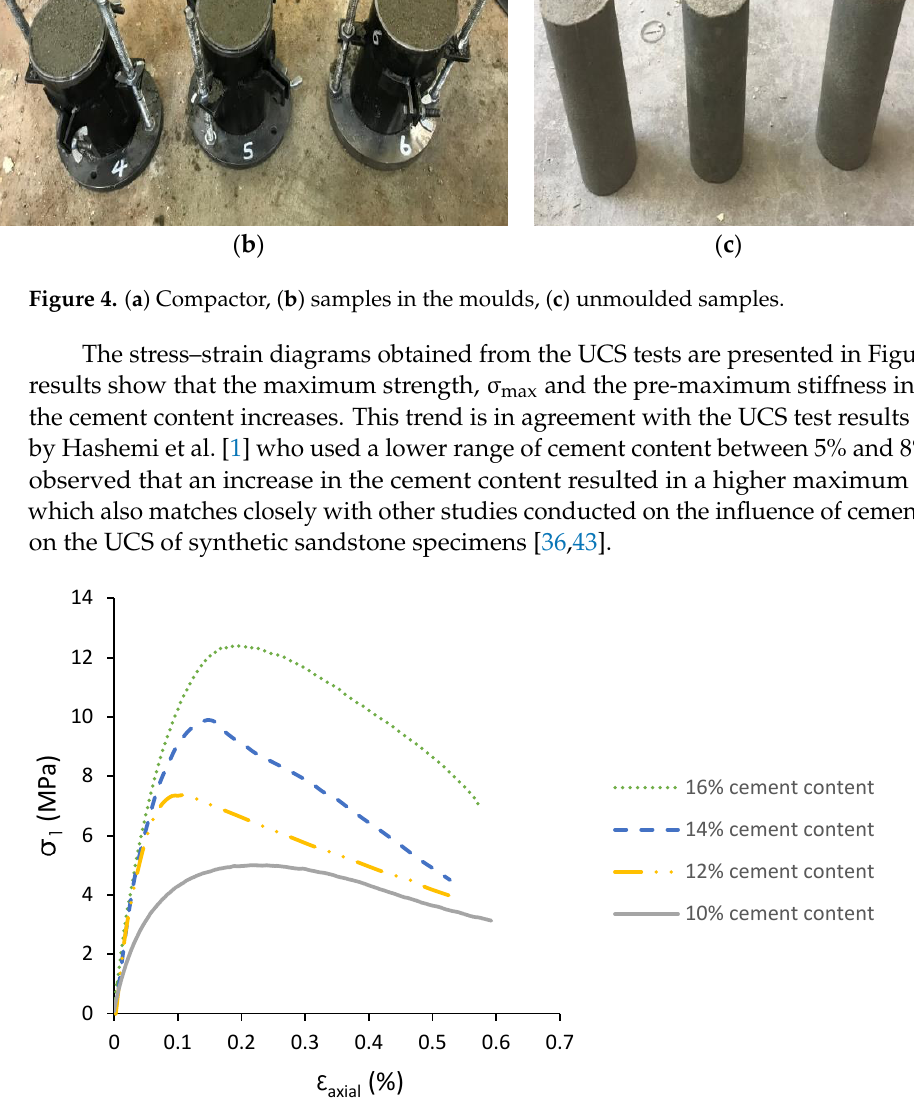
Figure 5. Stress versus axial strain behaviour for specimens subjected to UCS testing.